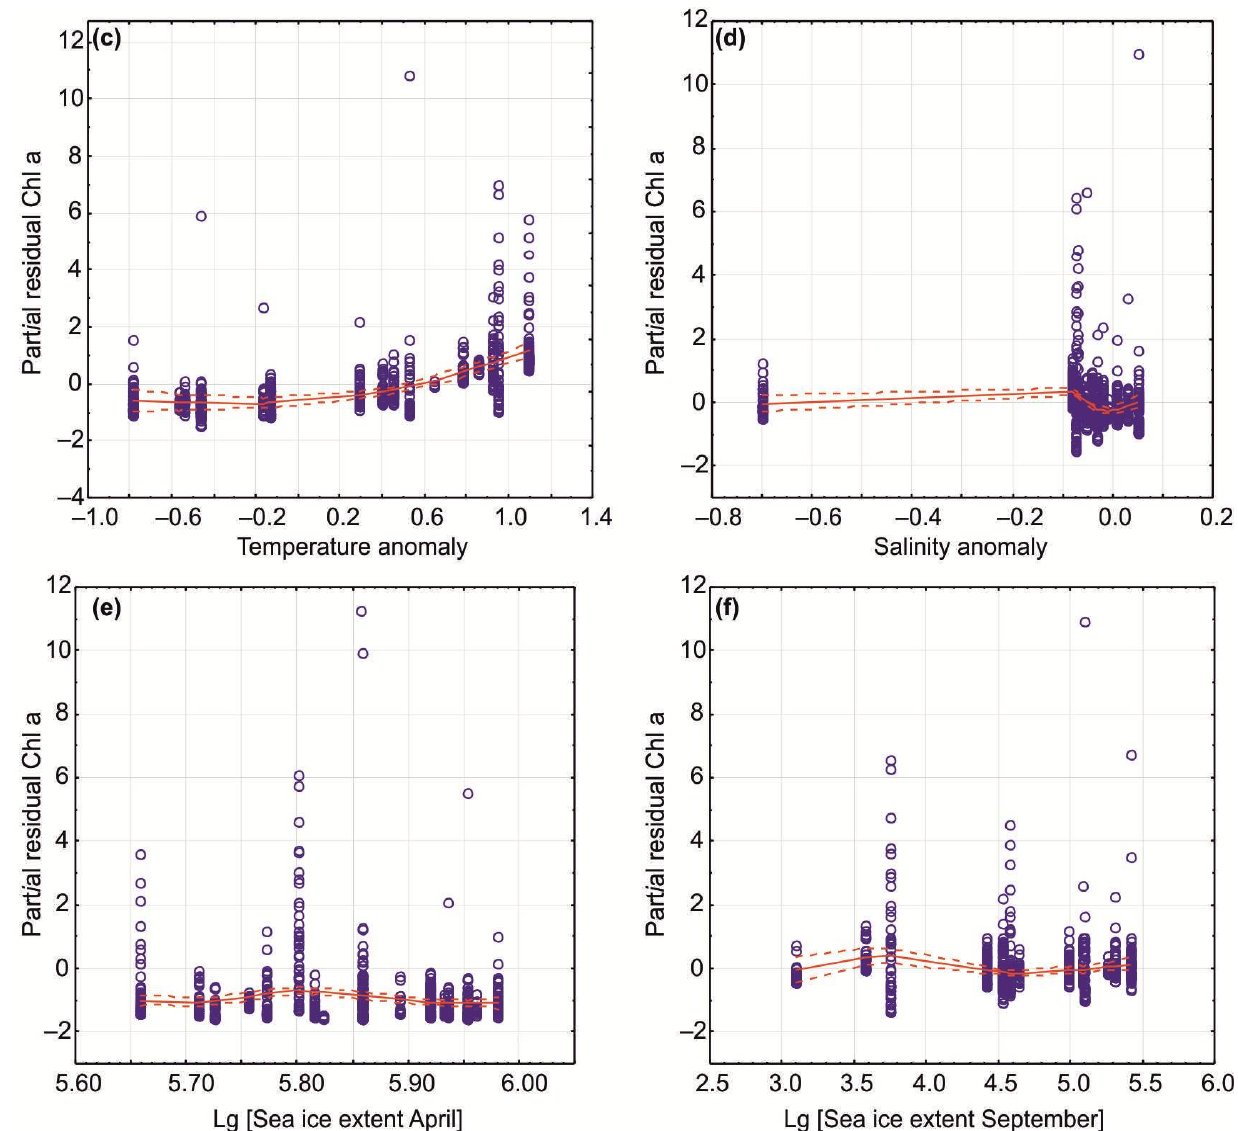
Figure 9. Significant GAM results (parametric, normal added functions) for Chl-a as a response variable in relation to climatic predictors as explanatory variables in the Barents Sea during the period 1984–2021. Smoothed best-fit lines with 95% confidence intervals for combined data (all seasons) are presented. Climatic predictors: ( a )—SST; ( b )—annual NAO index; ( c )—temperature anomaly at the Kola Section; ( d )—salinity anomaly at the Kola Section; ( e )—sea ice extent in April; ( f )—sea ice extent in September. Table 6. GAM assessed Chl-a patterns in relation to selected climatic predictors in the Barents Sea during the period of 1984–2021 using parametric (Normal) and non-parametric (Poisson) added functions.